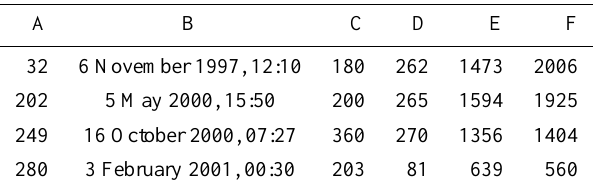
Table 5. Limb halo CMEs without any association to ICMEs near Earth. The meaning of the columns: ( A ) number of event in catalog at http://star.mpae.gwdg.de/cme effects/, ( B ) time of first appear- ance of CME front in LASCO-C2 field-of-view, ( C ) angular width of CME, ( D ) position angle of fastest CME feature (measured coun- terclockwise from North Pole), ( E ) plane of the sky speed V PS (in km/s) of fastest CME feature, measured between 10 and 20R s using C3, ( F ) expansion speed V exp (in